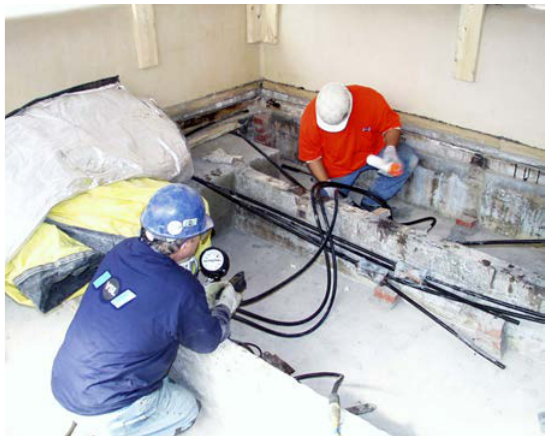
Figure 1. Page from the existing conditions survey (Wank Adams Slavin Associates,